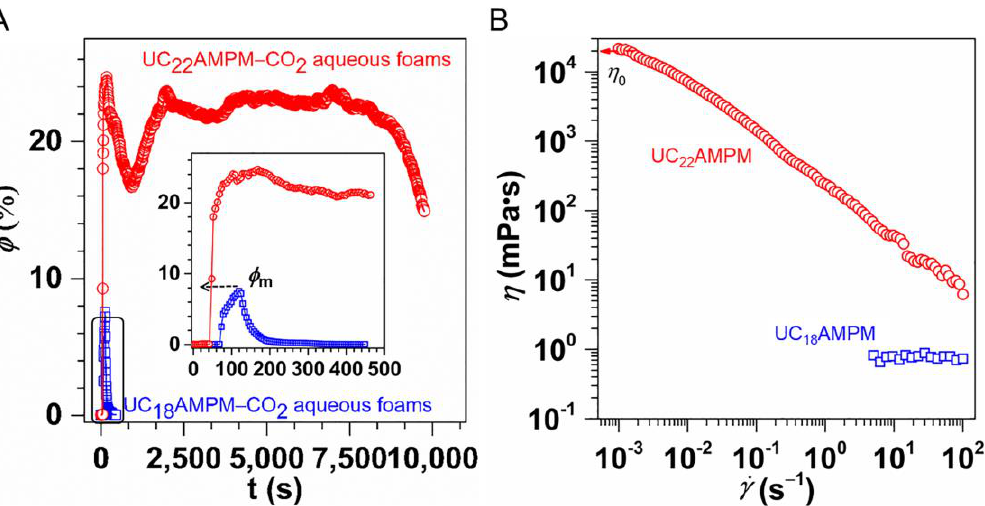
Figure 3. ( A ) Variation of the liquid content ( ϕ ) for 0.5% UC 22 AMPM and 0.5% UC 18 AMPM as a function of time. ( B ) Shear viscosity ( η ) plotted as a function of shear rate for 0.5% UC 22 AMPM and 0.5% UC 18 AMPM solutions at 35 C.